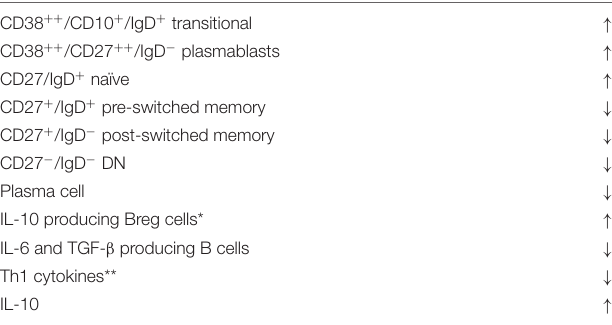
TABLE 4 | Autologous hematopoieitic stem cell transplantation effects on B cell subsets and cytokine production in patients with